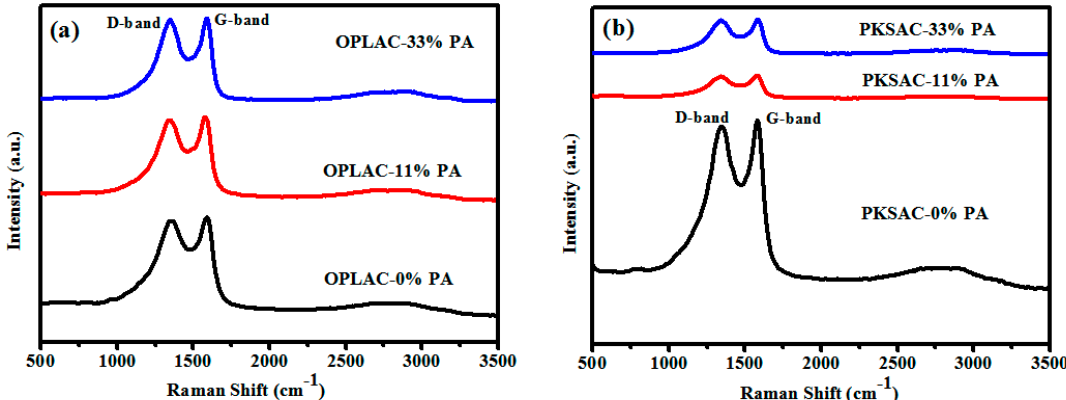
Figure 5. The Raman spectra of: ( a ) OPL-derived activated carbon (AC); and ( b ) PKS-derived activated carbon (prepared using different concentrations of H 3 PO 4 ), showing D- and G-bands.